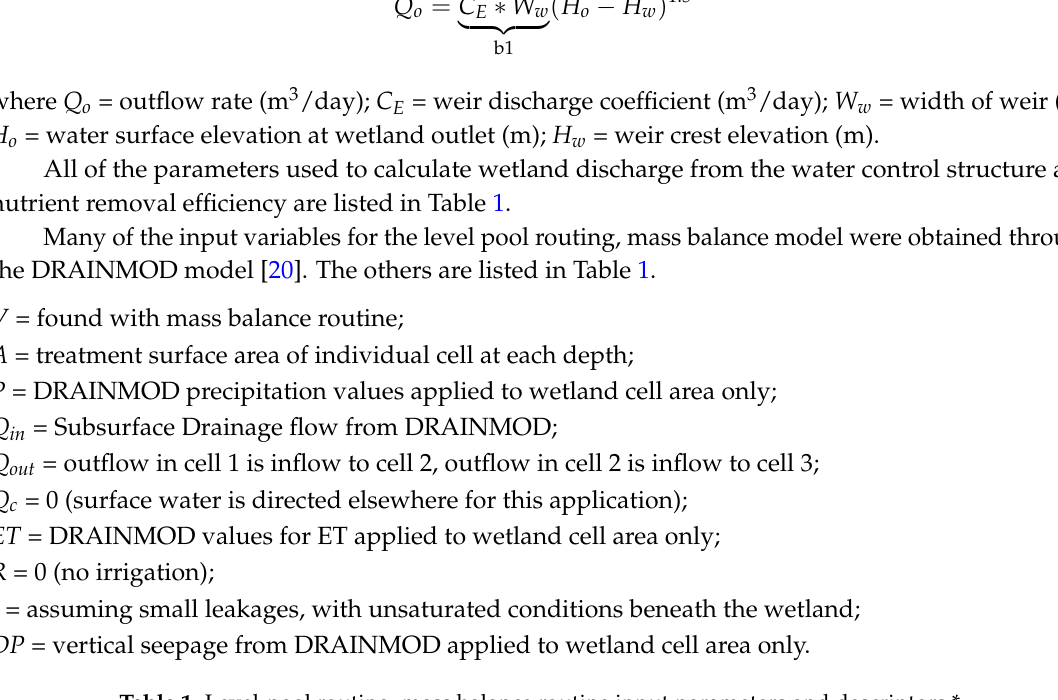
Table 1. Level-pool routing, mass balance routine input parameters and descriptors